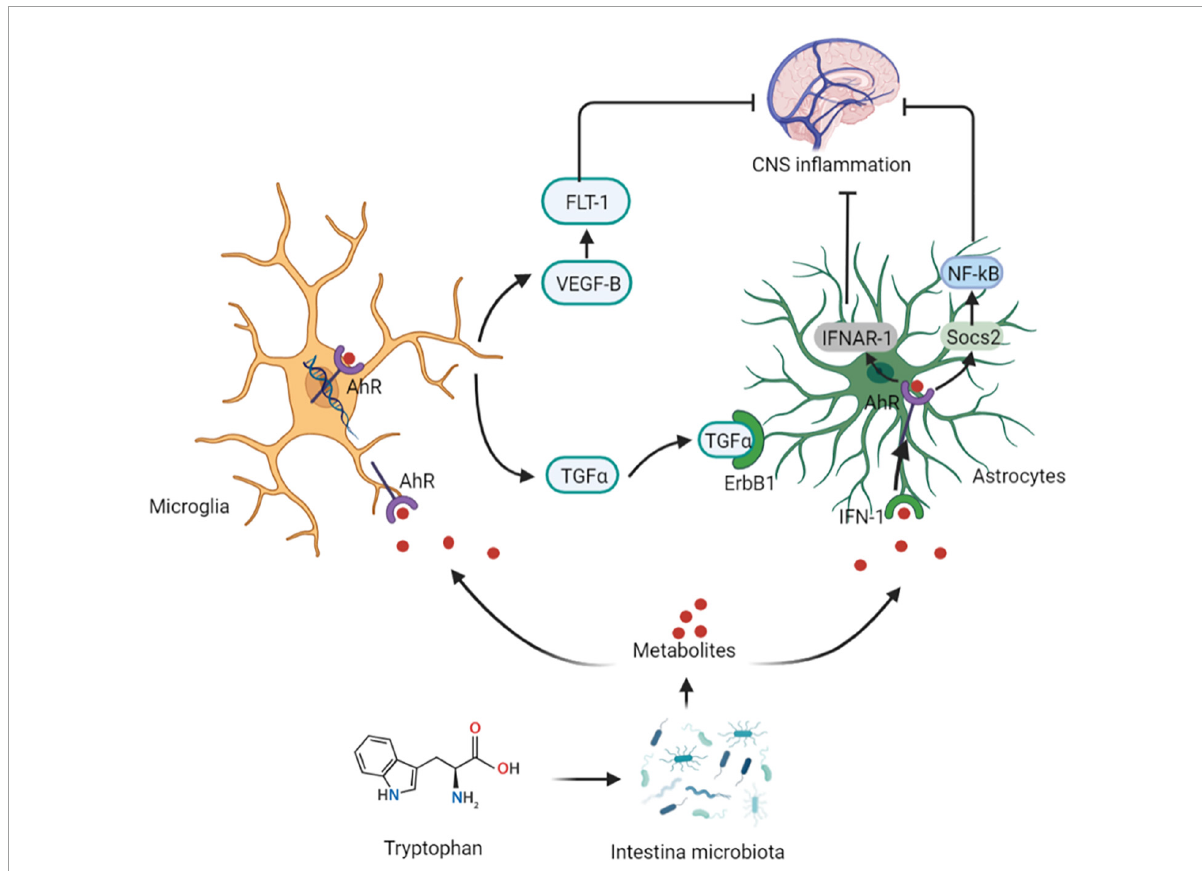
FIGURE3 Tryptophan affects central nervous system activity. The protective effect of the AhR ligand on CNS autoimmunity is through the IFN-I-AhR-Socs2-NF- κ B signaling pathway. Microglia can send signals to astrocytes to mediate the response to the inflammatory in CNS. The microbial metabolites of tryptophan regulate the microglial activation, produce TGF α and VEGF-B, regulate CNS-related diseases, and the transcription in astrocytes through AhR. Microglia derived-TGF α can bind to the ErbB1 in astrocytes to show exert neuroprotective effects. In contrast, VEGF-B production triggers FLT-1 signaling in astrocytes. AhR, aryl hydrocarbon receptor; IFN-I, Type I interferon; Socs2, suppressors of cytokine signaling 2; IFNAR-1, AhR-mediated interferon- α receptor-1; TGF α , transforming growth factor-alpha; VEGF-B, vascular endothelial growth factor B; ErbB1, epidermal growth receptor; FLT-1, endothelial growth factor receptor